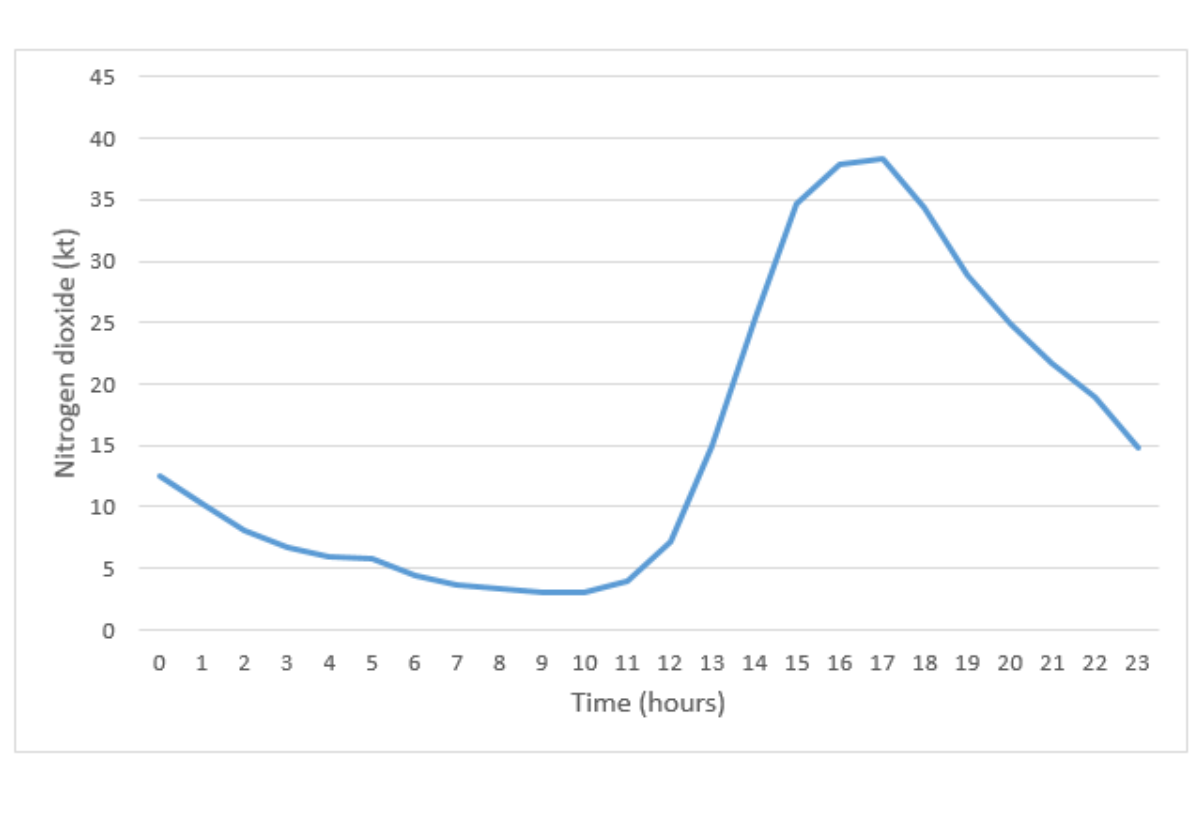
September/October 2021